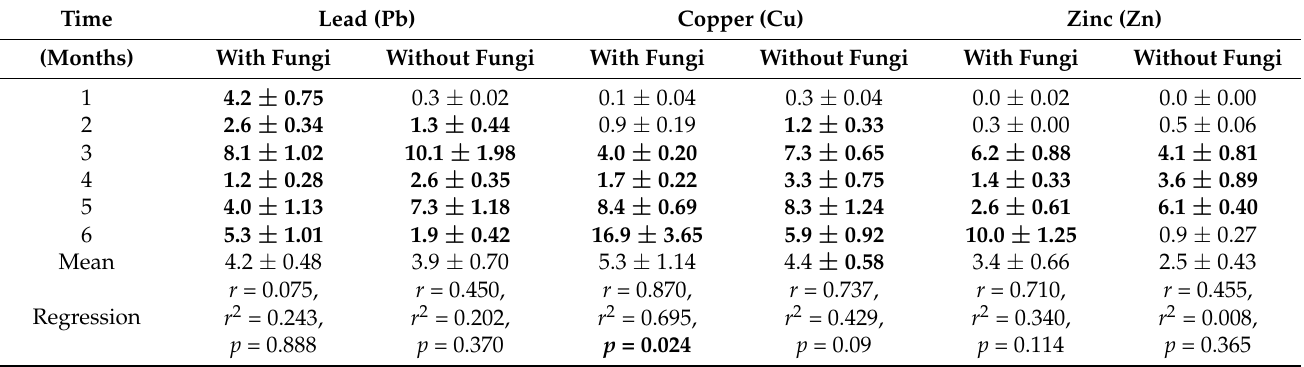
Table 5. Mean ( ± standard error) and simple regression analysis between exposure time and translo- cation values (FT) of heavy metals in Prosopis laevigata growing under greenhouse conditions. Bold letters denote FT values greater than one and denote significant differences in regression